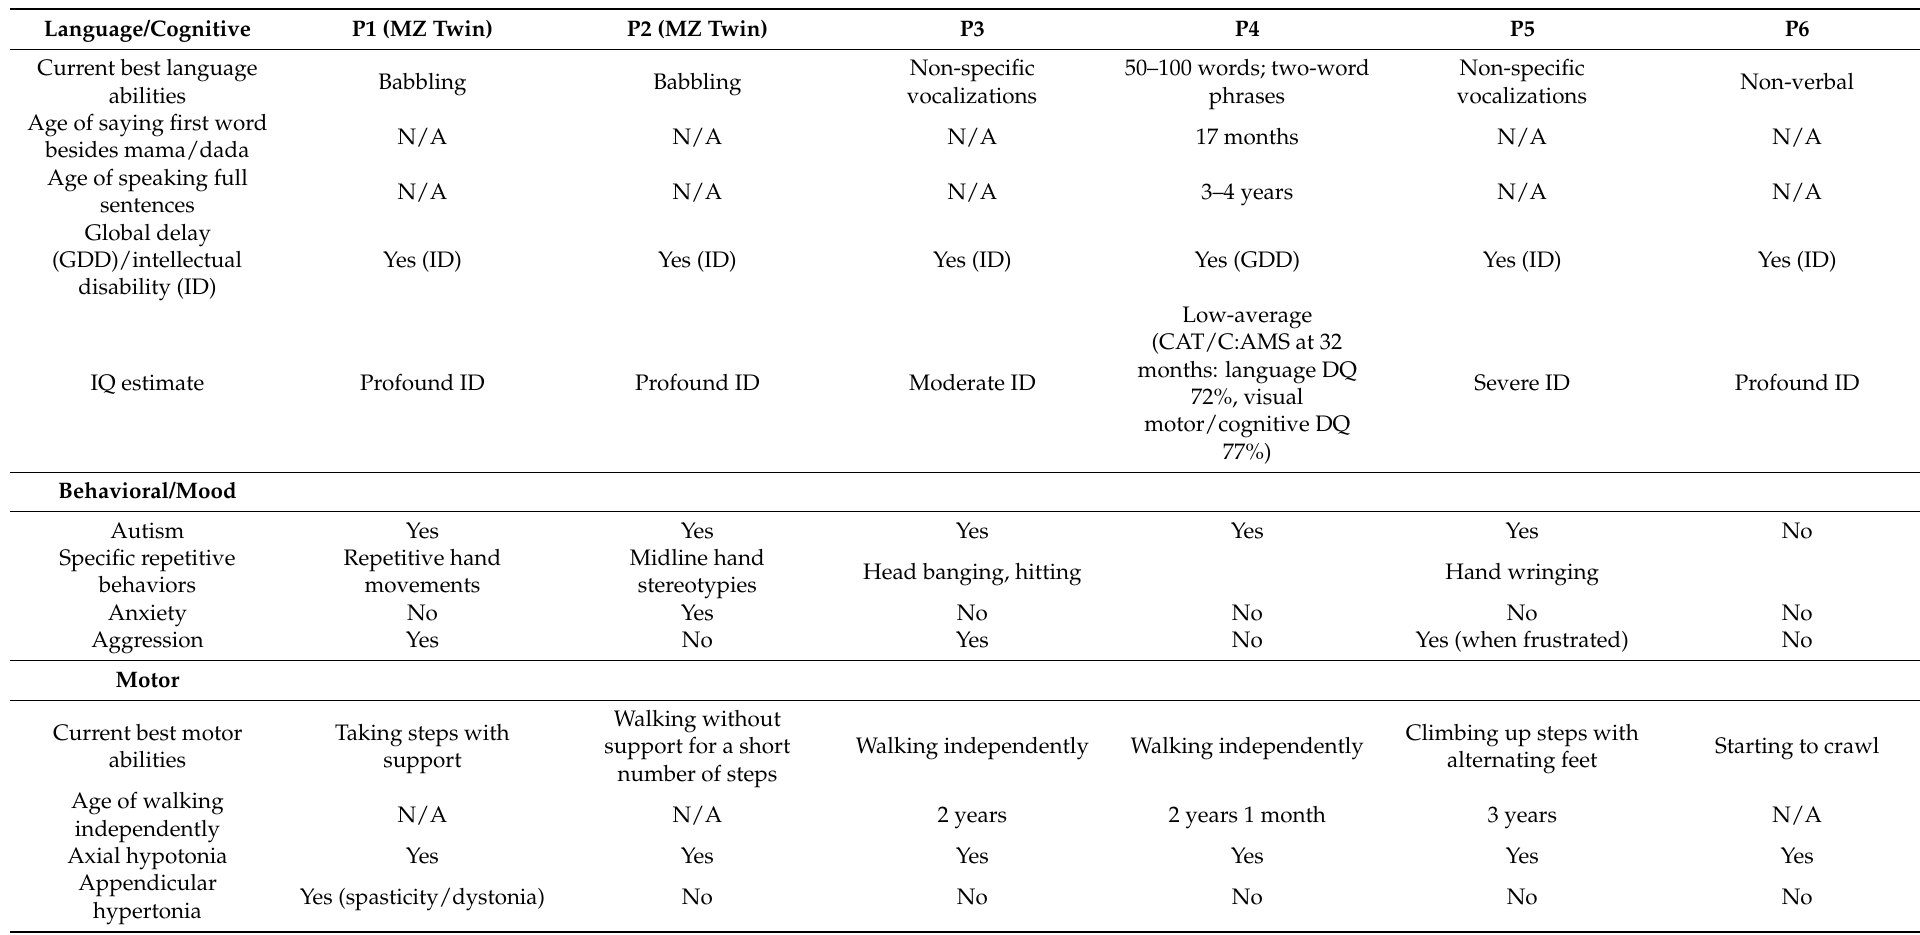
Table 2. Neurological and developmental features of the